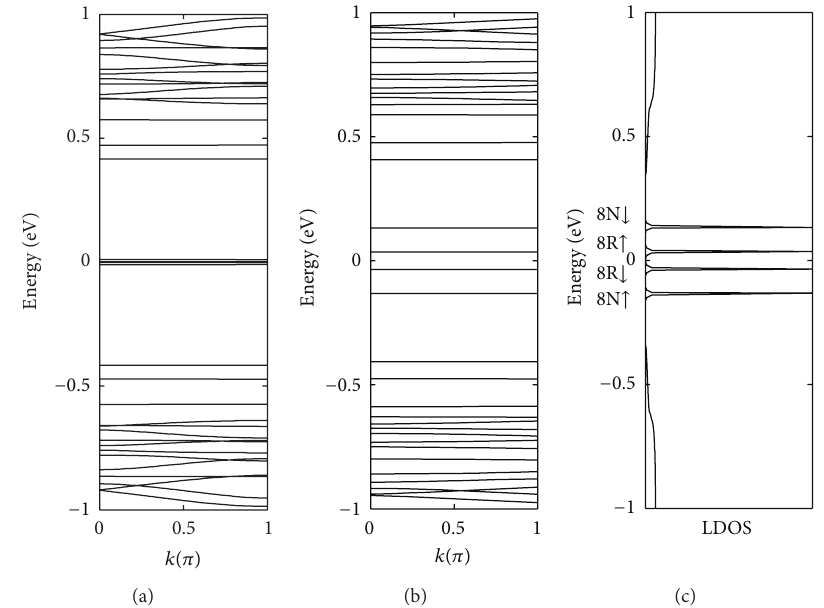
Figure 6: Comparison of band structures of 12(8,0)/12(14,0) SL calculated with the TB (a) and Hubbard (b) models. In the Hubbard model all bands are spin degenerate. (c) LDOS at a single junction, including the Coulomb repulsion (the peaks positions correspond to the flat bands presented at (b)). Arrows and letters R/N indicate spin polarization and localization at the 8R and 8N octagons,